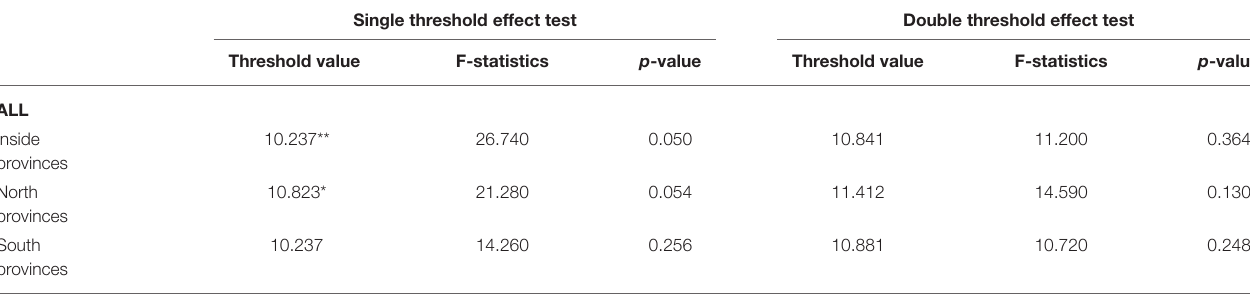
TABLE 3 | Test for threshold between Urbanization and Population health.